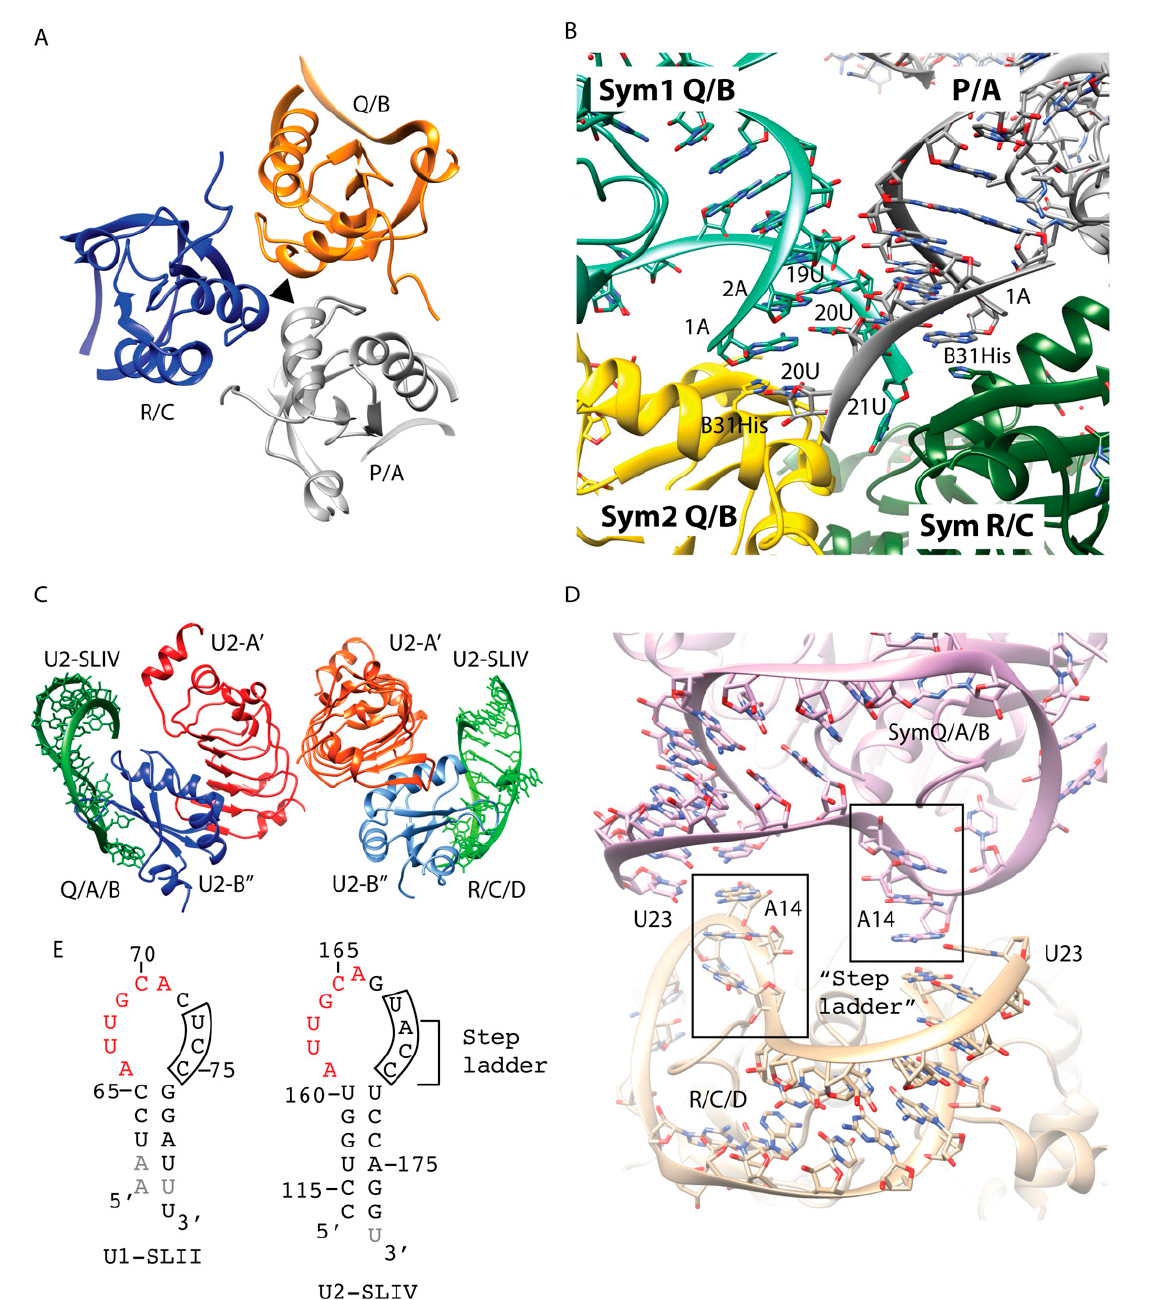
Figure 2. Hairpin structures of U1-SLII and U2-SLIV. ( A-B) U1A/U1-SLII (PDB:1URN). ( A ) Three NCS copies related by a 3-fold axis are present in the asymmetric unit. The complex is named after the chain ID. A, B, C: U1A and P, Q, R: U1-SLII. Only protein-protein interactions are observed between the NCS complexes. ( B ) Close up of the protein-RNA interaction between the NCS copies. The Y31H splits open the end pair (A1:U20) of the stem loop of P/A. ( C-D) U2A (cid:48) B (cid:48)(cid:48) /U1-SLIV (PDB:1A9N) . ( C ) Two NCS copies are present in the asymmetric unit. The complex is named after the chain ID. A, C:U2-A (cid:48) ; B, D:U2-B (cid:48)(cid:48) ; Q, R:U2-IV. Interactions between U2-A (cid:48) are the only contacts between the NCS complexes. ( D ) The sequence A14, C15, C16 at the 3 (cid:48) end of the loop forms a step ladder structure. A14 forms a Hoogsteen to WC base pair with the 3 (cid:48) sticky U23. ( E ) The hairpin loop sequence of U1-SLII and U2-SLIV. The 5 (cid:48) 6 nt loop sequence (in red) are identical between the two RNAs whereas the 3 (cid:48) loop sequence confers binding specificity. Engineered sequence is colored in gray. U2B” is homologous to U1A, and its binding to the stem loop U2-SLIV requires U2A (cid:48) . The 6-nt (AUUGCA) at the 5 ′ end of the U2-SLIV hairpin loop is identical to that of U1-SLII (Figure 2E). Utilizing similar strategies to optimize end-to-end packing of the RNA